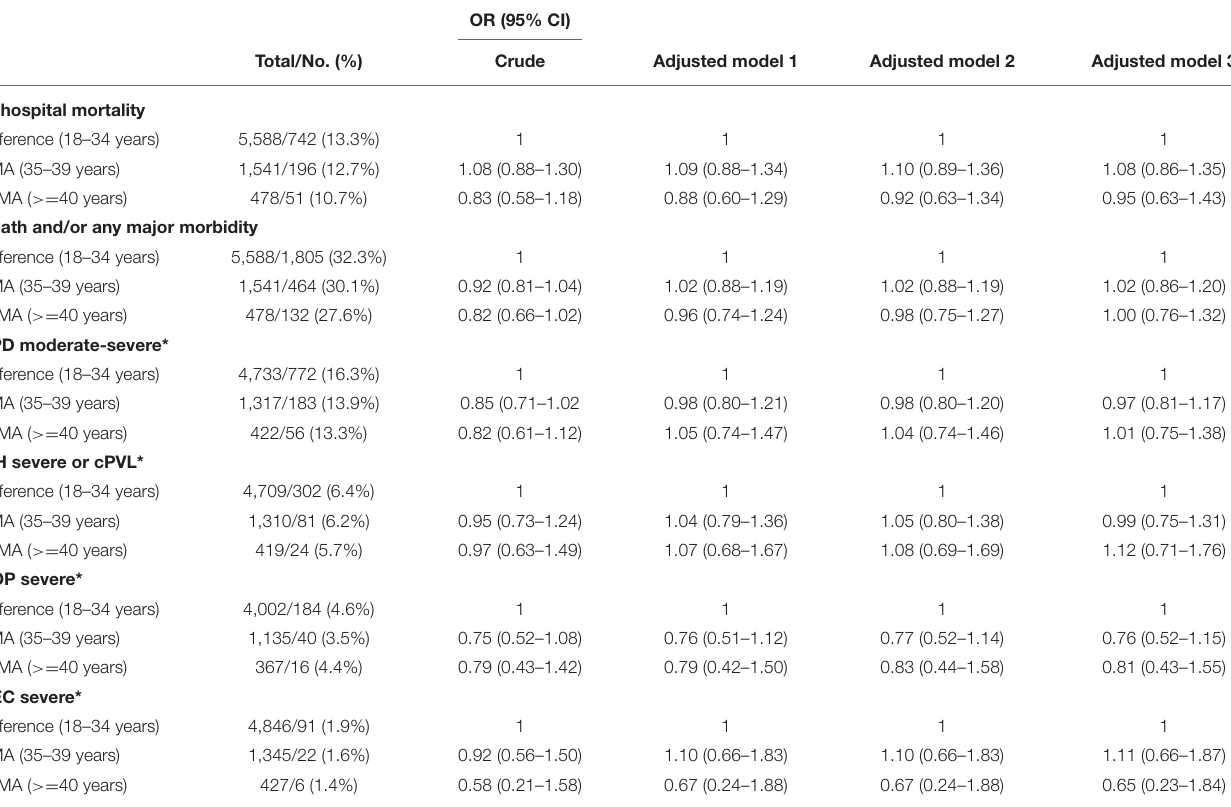
TABLE 3 | Multivariate logistic regression analysis for the association between maternal age and adverse neonatal outcomes in very preterm infants. OR (95%